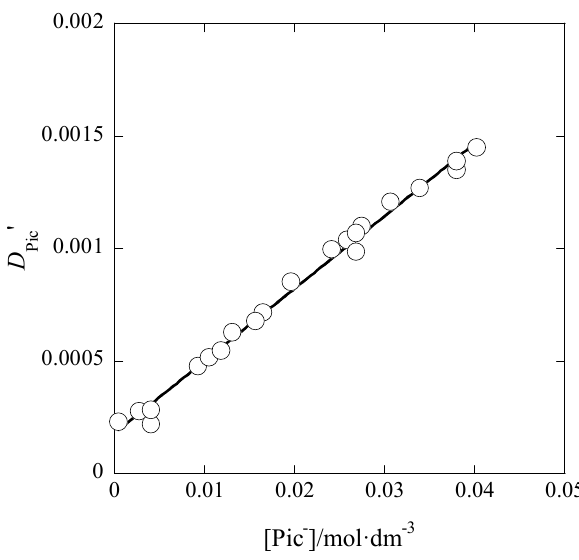
Figure 1. A plot of D Pic ′ vs. [Pic − ] for the AgPic extraction into 1,2-dichloroethane (DCE). The straight line was D Pic ′ = (1.81 × 10 − 4 ){1 + (1.81 × 10 − 4 )(9.81 × 10 5 )[Pic − ]} at r (correlation coefficient) = 0.996. Table 1. Fundamental data for the extraction with AgPic, AgClO 4 , or AgNO 3 (= AgA) and B18C6 (= L) into DCE at 298 K.